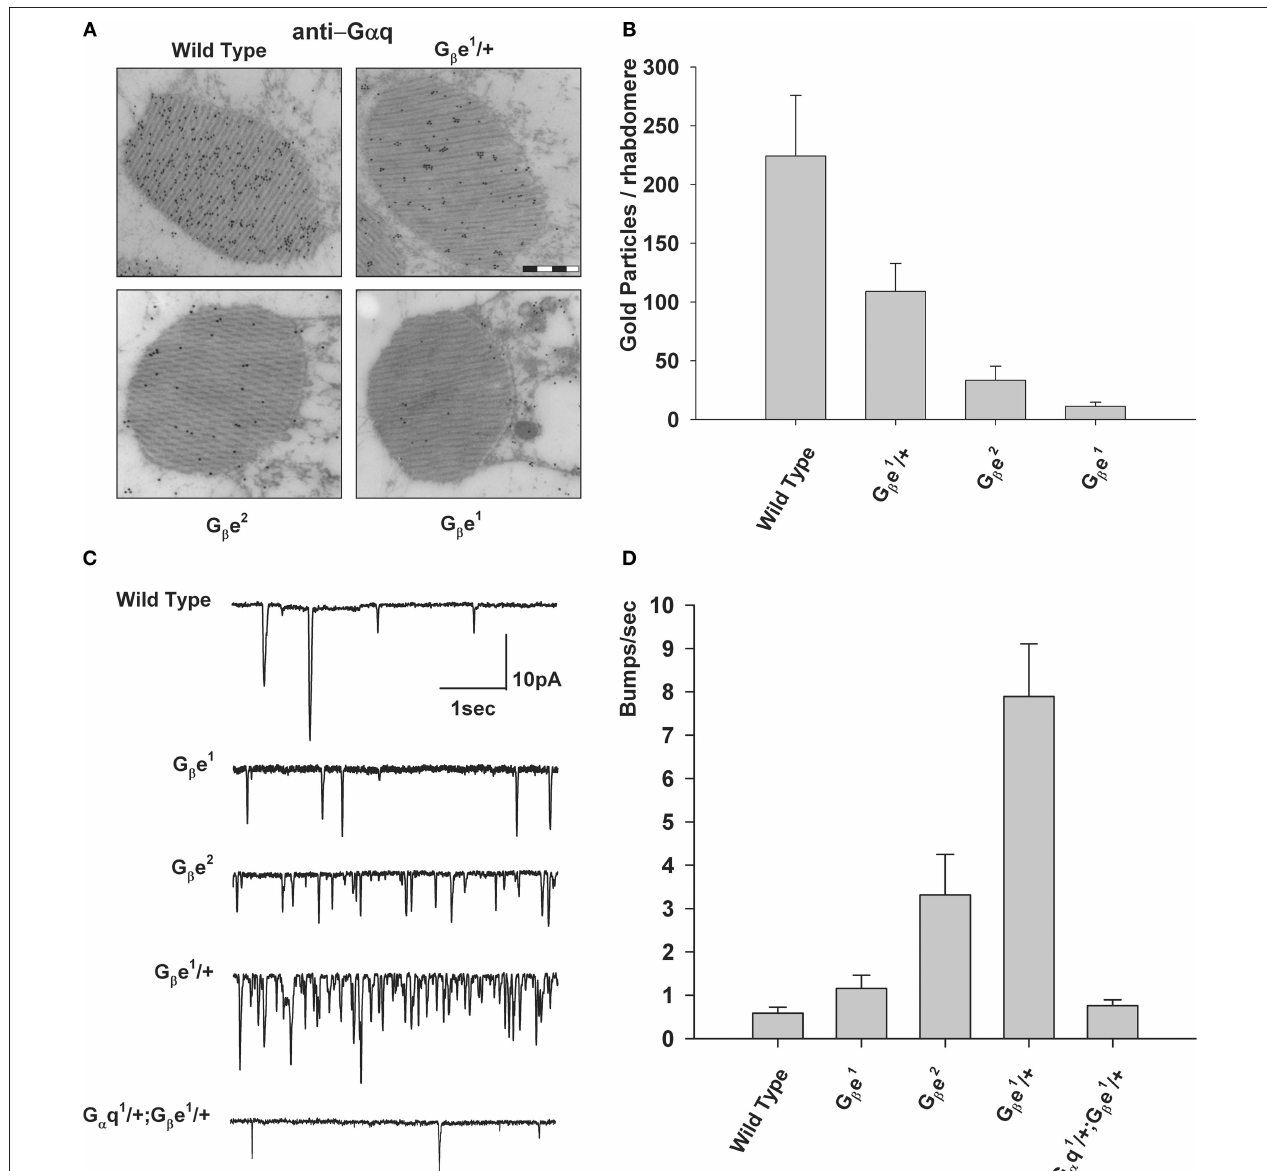
β over G α is required to prevent production of FIGURE 7 | Excess of G q q spontaneous bumps in the dark. (A) Immunogold EM analysis of a cross-section α antibody that was applied to dark adapted of a single rhabdomere, using a G q wild-type fl ies and G β mutants (bar 500 nm). (B) Number of mean gold particles in cross-sections of 20 different single rhabdomeres. Error bars are SEM. (C) Whole-cell